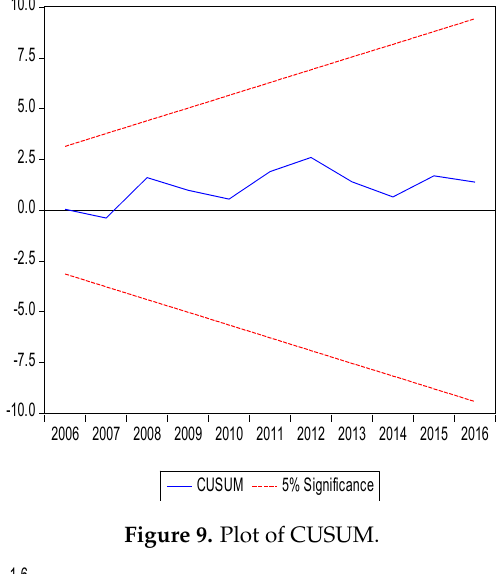
Figure 9. Plot of CUSUM. Appl. Sci. 2018 , 8 , x FOR PEER REVIEW